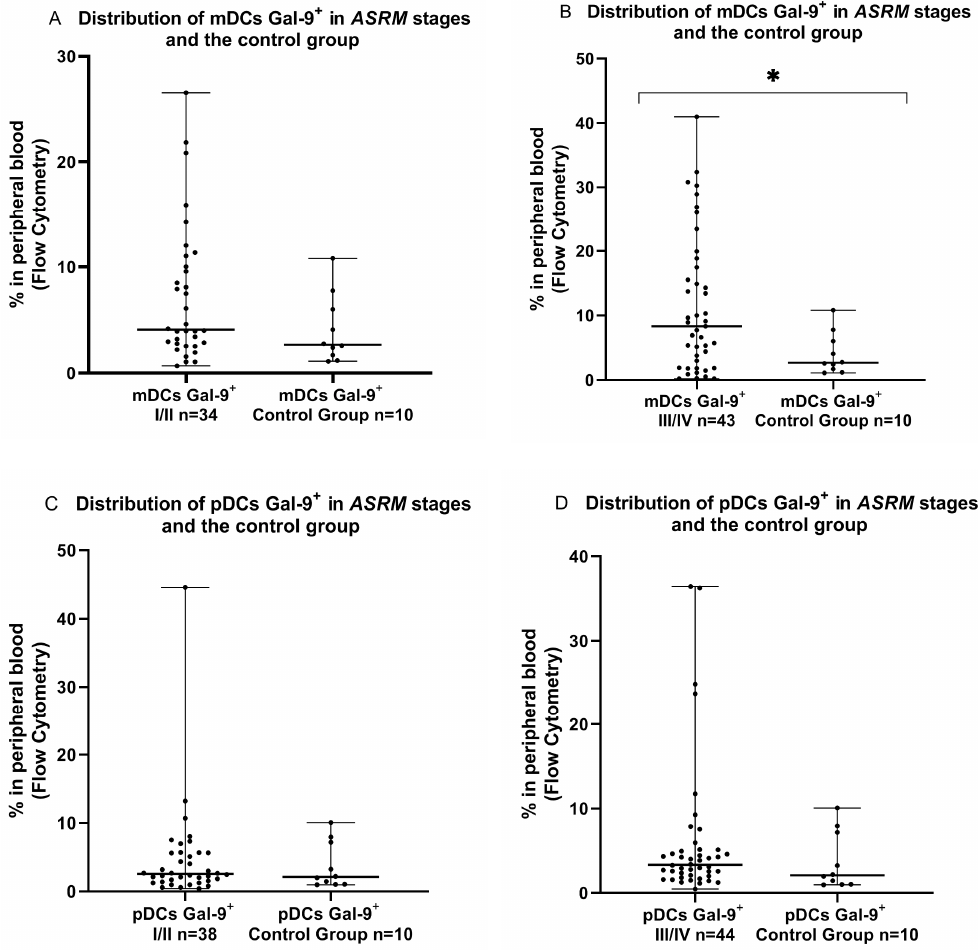
Figure 3. Percentage of mDCs Gal-9-positive and pDCs Gal-9-positive cells in peripheral blood ( A – D ) in early (I/II) and late (III/IV) ASRM stages of EMS and in the control group. The median values with the following sign indicate statistically significant differences: * p < 0.05.